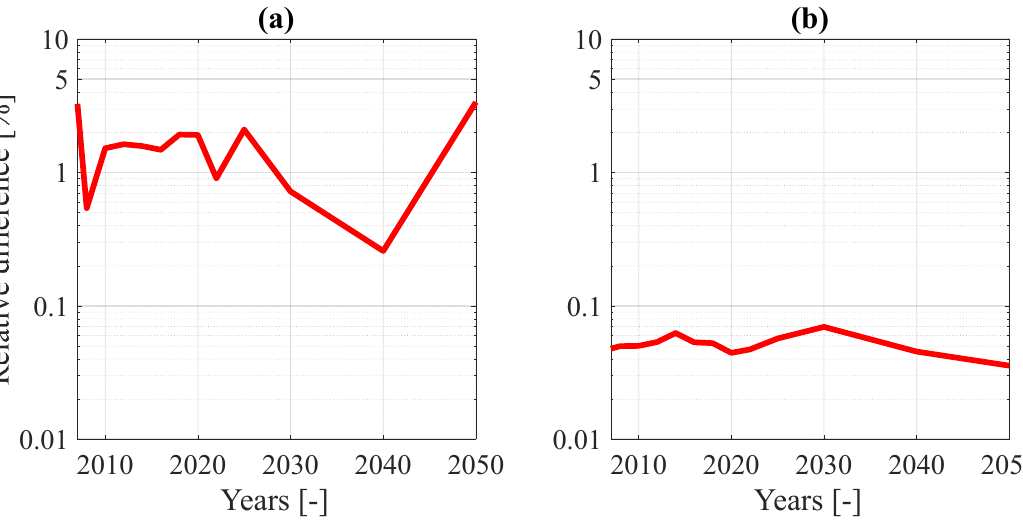
Figure 9. Average relative difference curves associated to the optimal technology mix for: ( a ) road transport categories; ( b ) non-road transport categories.